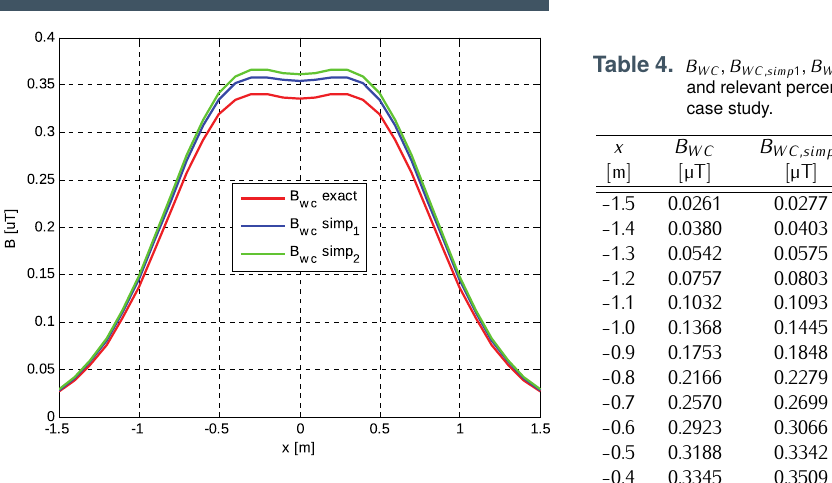
Figure 8. B WC , B WC,simp 1 , B WC,simp 2 versus horizontal distance x for the first case study.